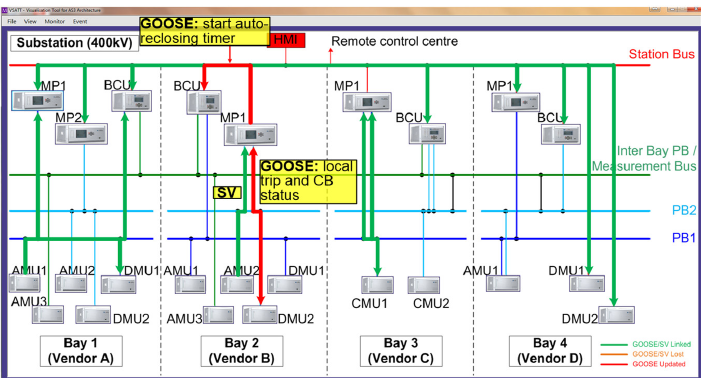
Figure 8. Example of the visualisation tool detecting GOOSE updated in bay 2. Table 3. Example of GOOSE events recorded by the visualisation